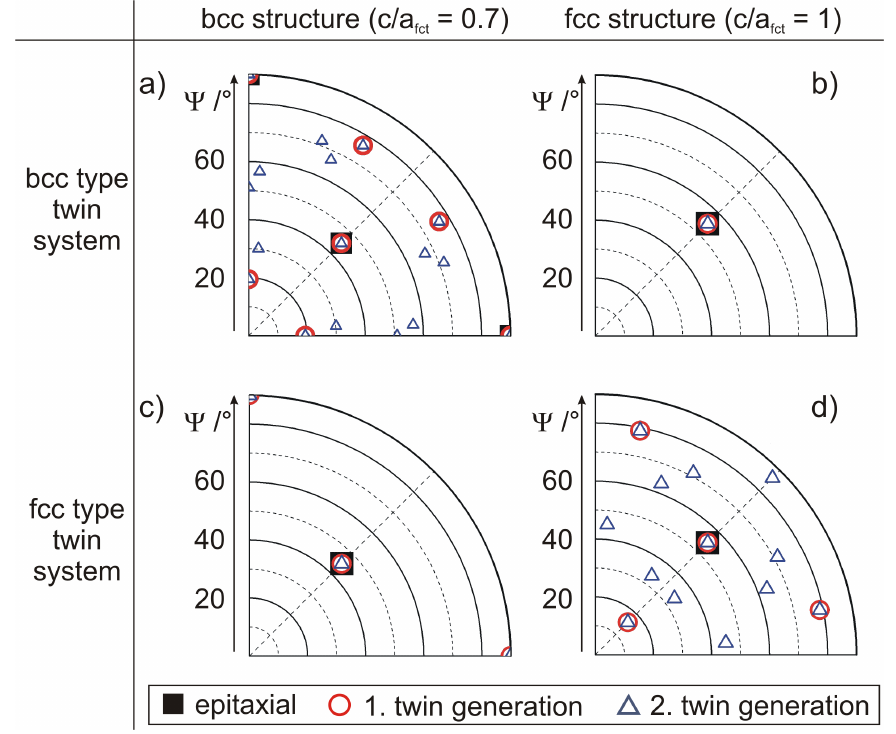
Pole figure simulation of bcc-type { 112 }